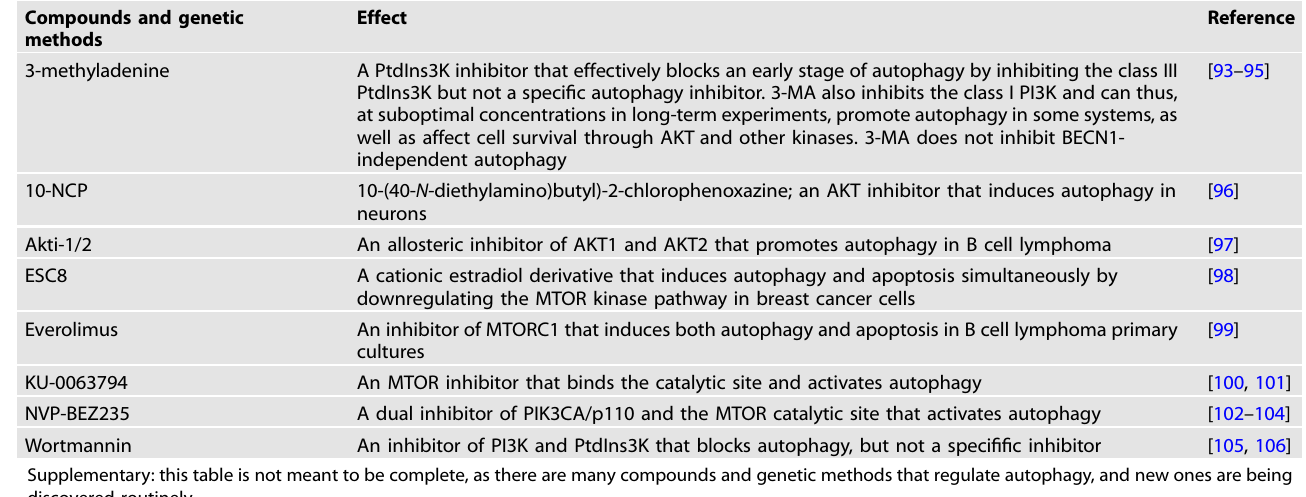
Supplementary: this table is not meant to be complete, as there are many compounds and genetic methods that regulate autophagy, and new ones are being discovered